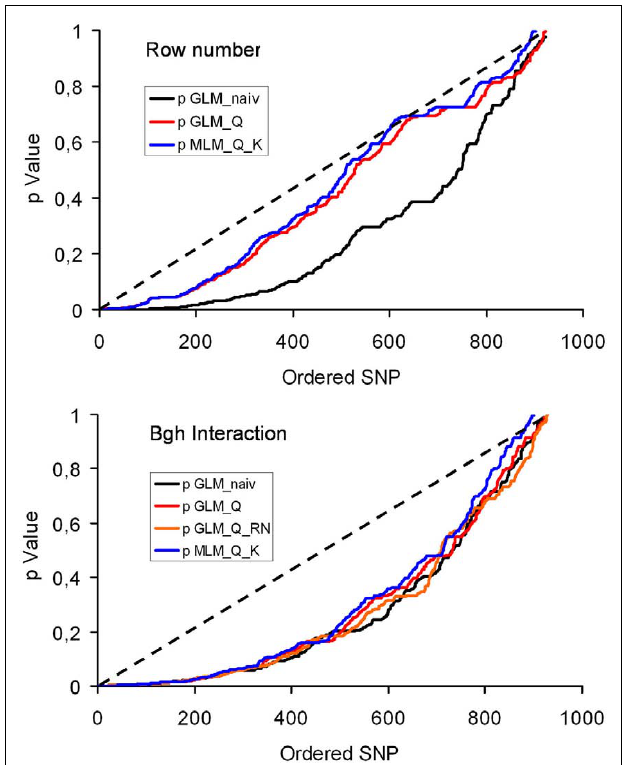
FIGURE 4 | Control for spurious associations of SNPs with two traits using four statistical models. p -Values of all identified SNPs are plotted in ascending order, and would lie on the diagonal if randomly distributed. Deviation of the distributions from the diagonal toward lower p -values indicates insufficiently corrected population structure or non-random selection of genes. No data for the trait “row number” using the general-linear model plus row number as covariate are shown because this caused statistical significance to collapse, as